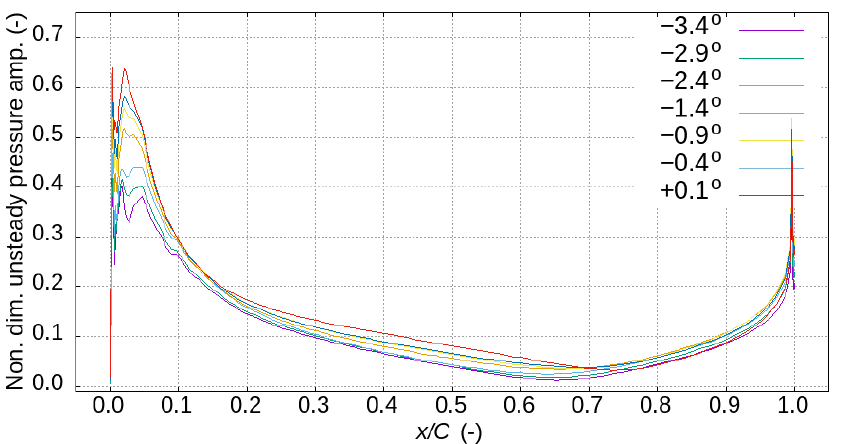
Figure 14. Profiles of Fourier decomposed unsteady pressure amplitudes on the OGV pressure surface for varying β .